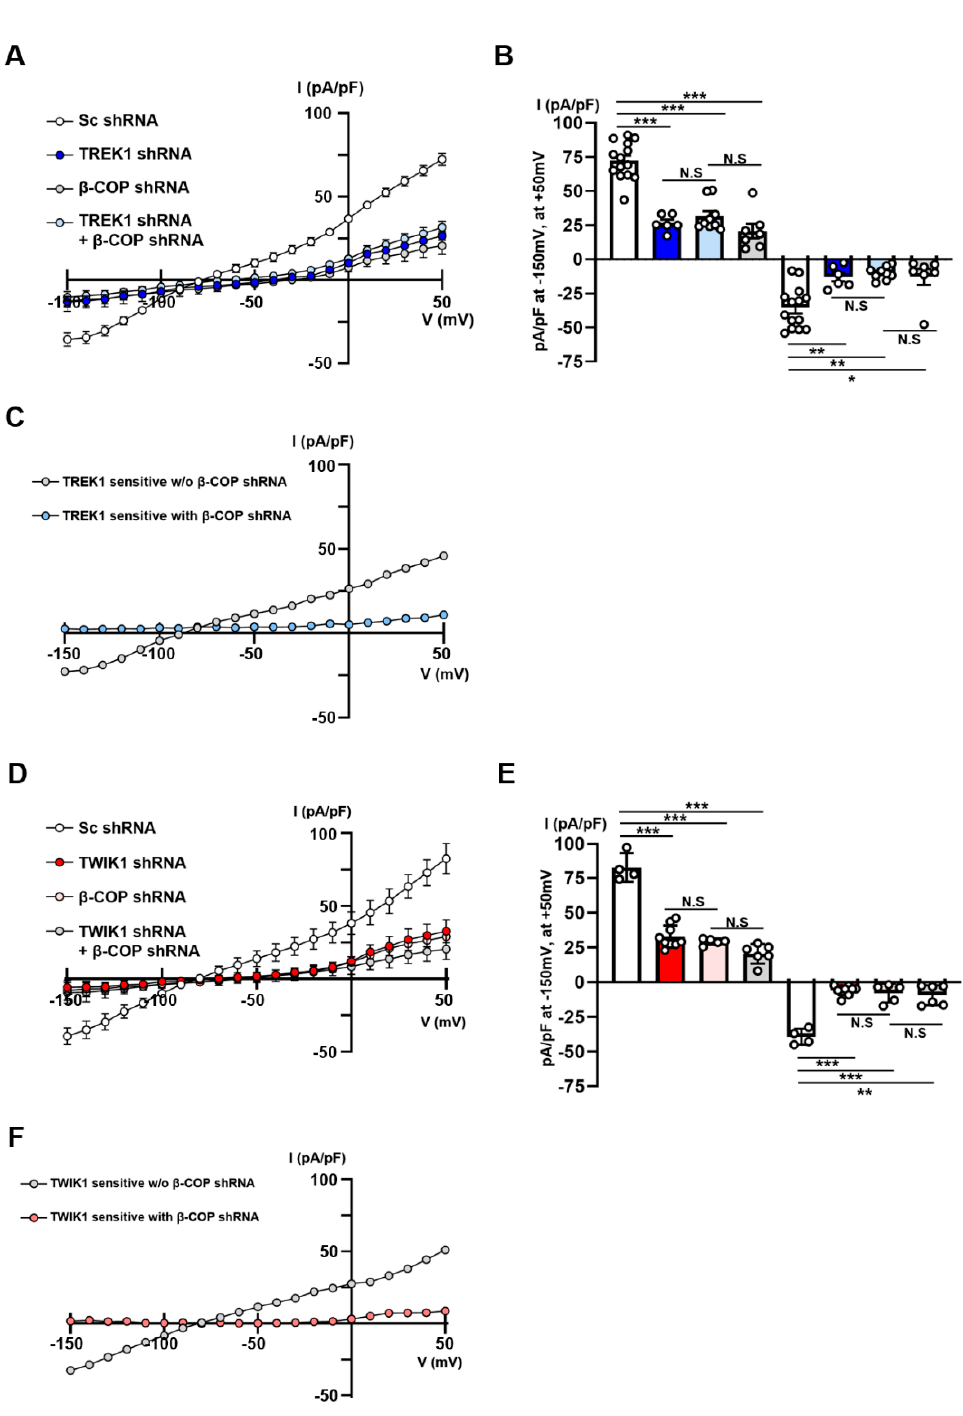
Figure 6. Knockdown of β -COP downregulates TWIK1/TREK1-mediated currents in astrocytes. ( A ) Average current-voltage ( I - V ) relationship of whole-cell K + currents in cultured astrocyte trans- fected with Sc shRNA , TREK1 shRNA, β -COP shRNA, or TREK1 shRNA + β -COP shRNA. ( B ) Summary bar graph showing averaged currents at +50 mV and − 150 mV in ( A ). All values are